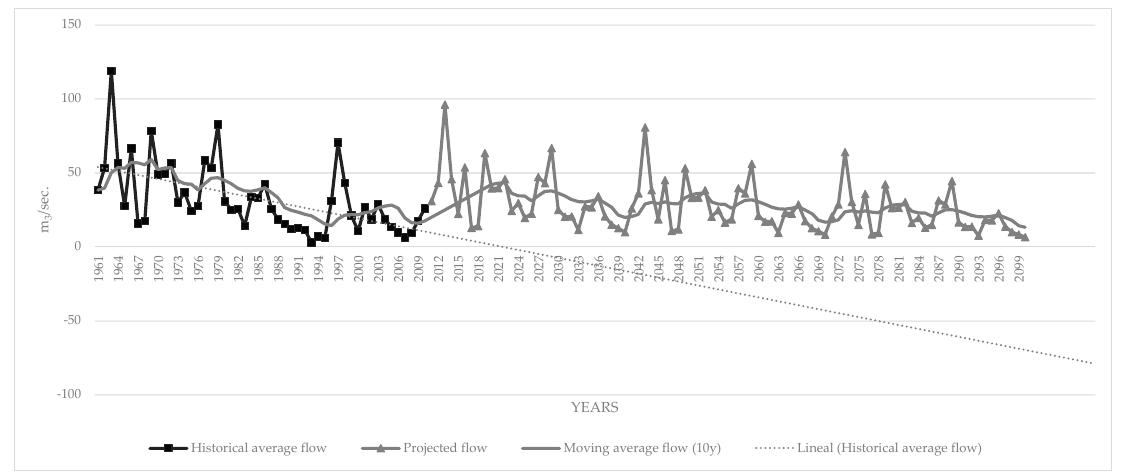
Figure 12. Historical and projected flow (m 3 /s), Mengibar center. Source: Own elaboration and ENDESA.